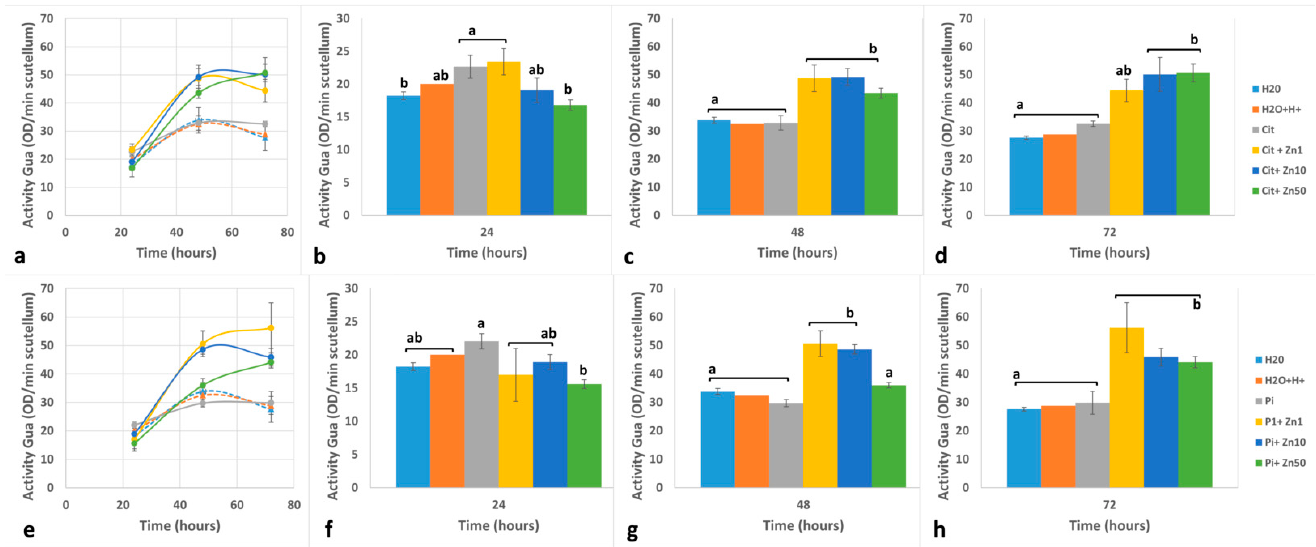
Figure 5. Effect of zinc on the activity of peroxidase quantified with guaiacol + H 2 O 2 as substrates (POD-Gua) from maize scutellum. Embryos were imbibed for 24 to 72 h in H 2 O, H 2 O+H+, Cit, Cit+Zn1, Cit+Zn10, Cit+Zn50, Pi, Pi+Zn1, Pi+Zn10, or Pi+Zn50, and activity was determined using guaiacol + H 2 O 2 as substrates. ( a ): Cit; ( e ): Pi. Imbibition times were ( b , f ): 24 h; ( c,g ): 48 h; ( d,h ): 72 h, in Cit or Pi, respectively. The data represent the mean ± SE of n = 3 to 6 independent assays. ANOVA was performed, followed by the Tukey–Kramer multiple comparison test, with p < 0.05 representing significance. Letters that are the same indicate similar variations, and different letters indicate significant differences at each imbibition